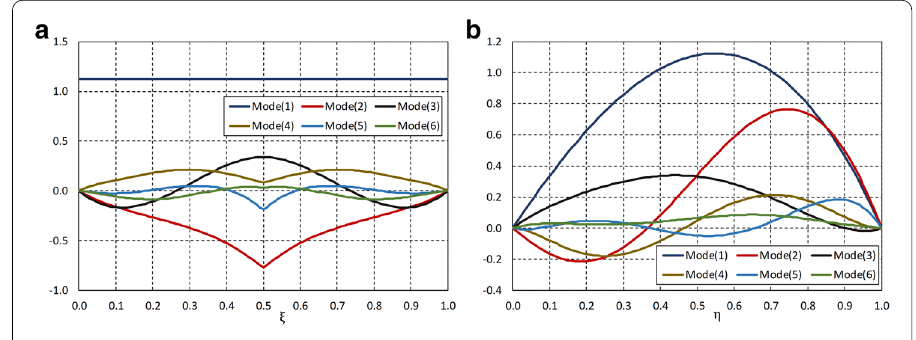
Fig. 3 Six-modes separated representation of the temperature field: Modes in ξ ( a ) and in η ( b )